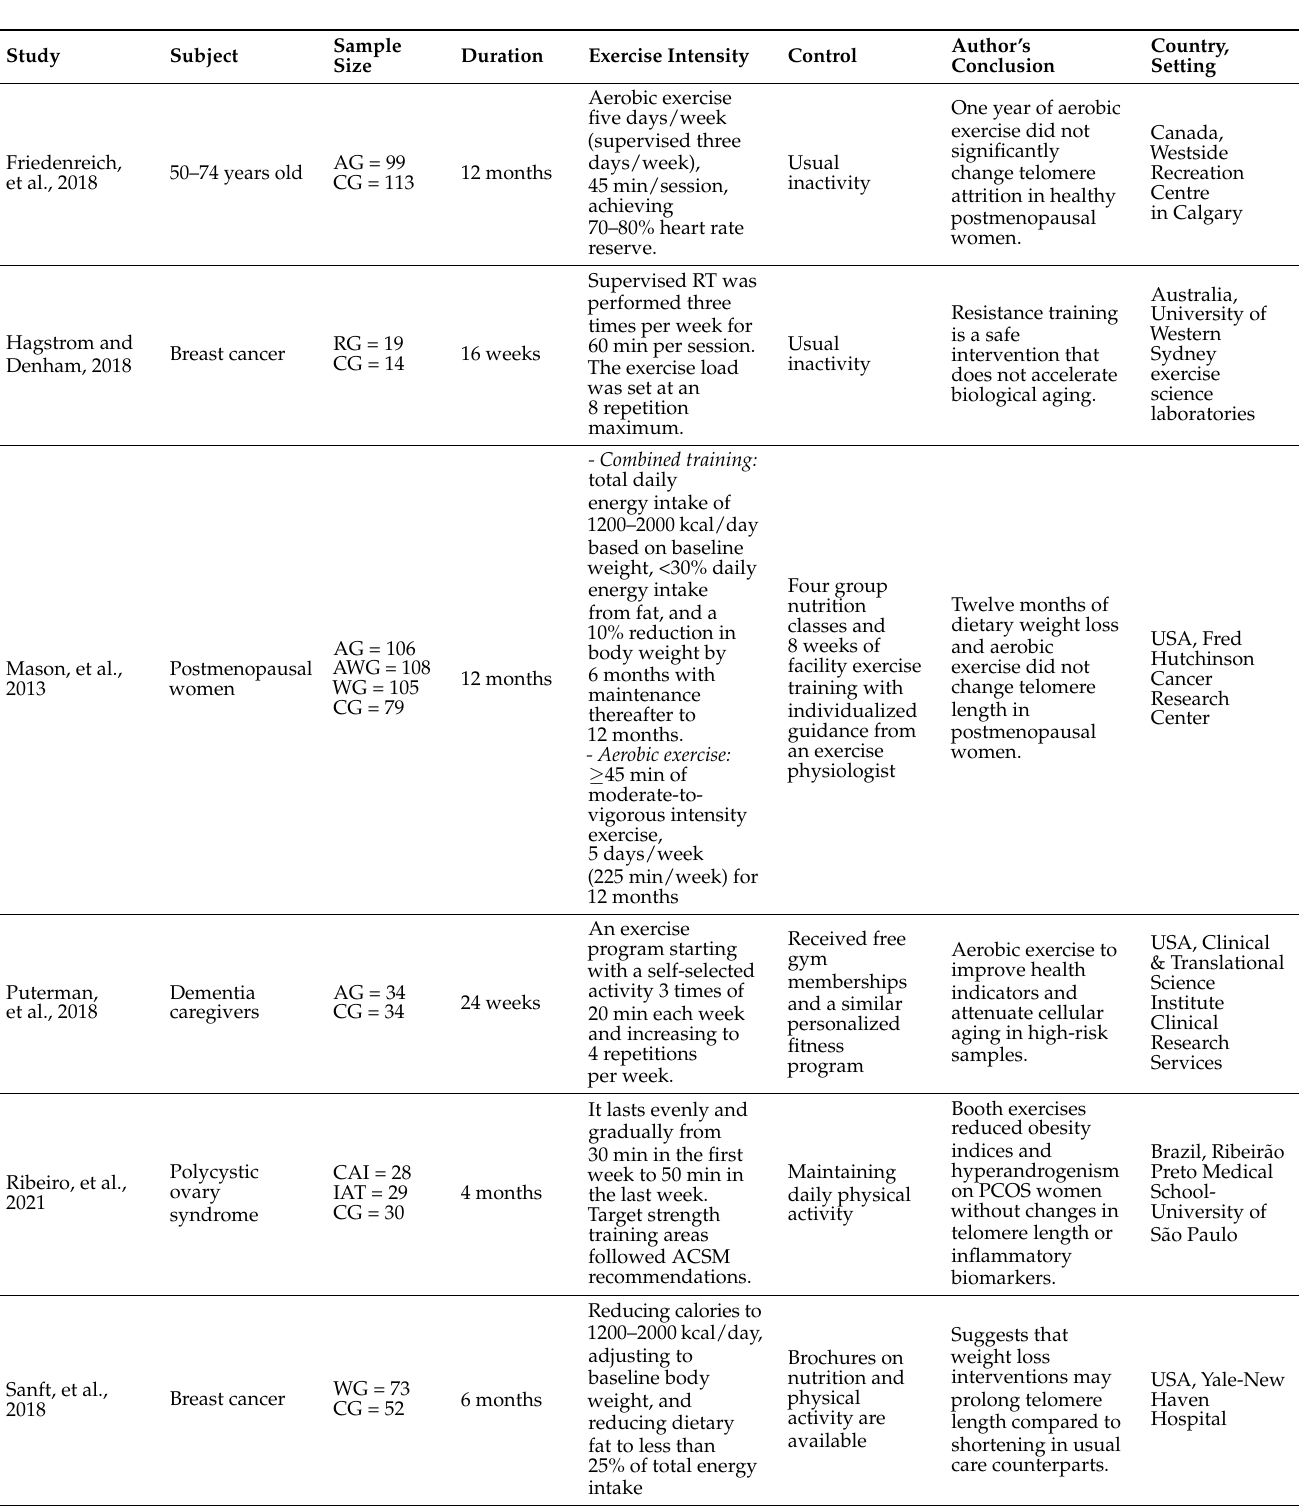
Table 1. Characteristics of included